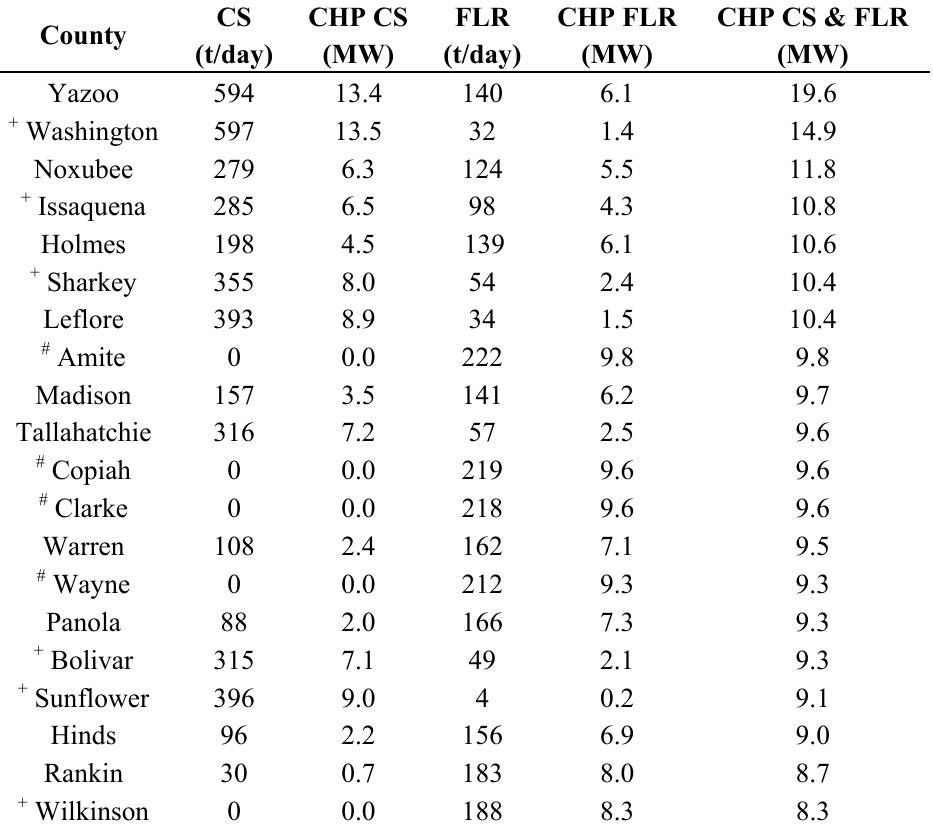
Table 2. Counties with potential CHP capacity of more than 8 MW based on combined use of corn stover and forest logging